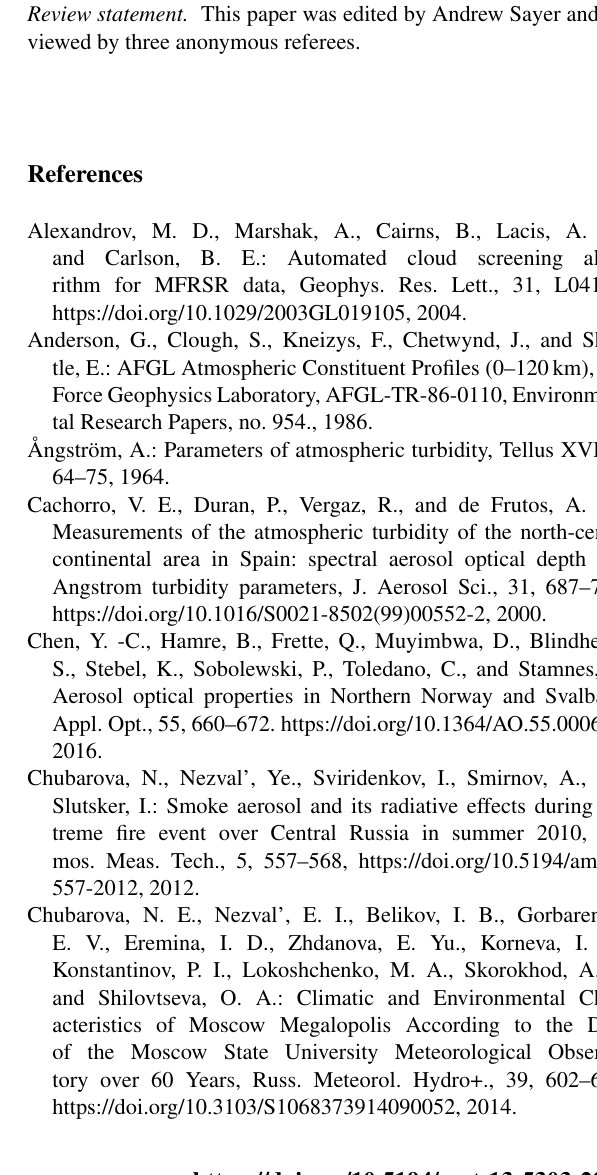
and (b) τ c in spring and fall in two regions on Spitsbergen 0 . 5